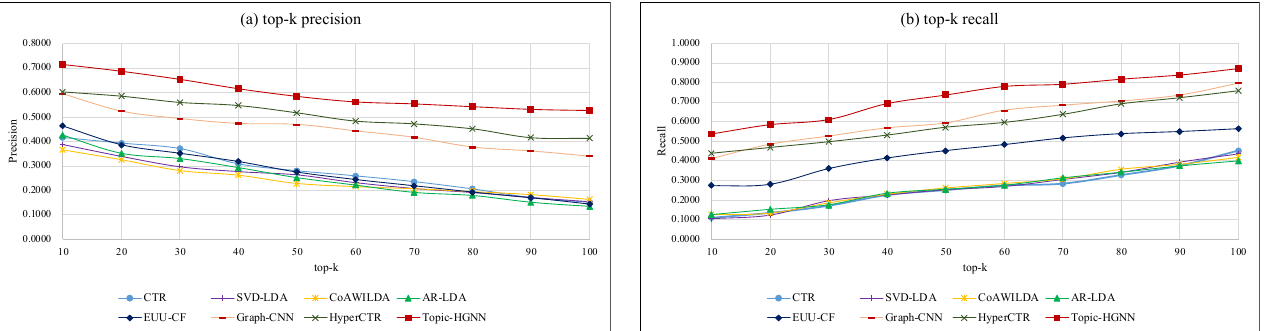
Figure 5. Comparison of recommendation result accuracy: ( a ) precision of top ‐ k items; ( b ) recall of top ‐ k items.